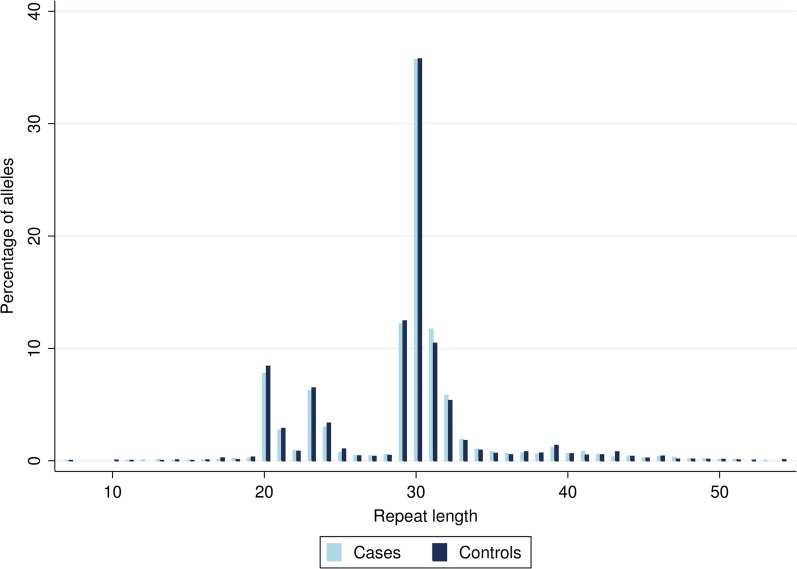
Percentage of FMR1 alleles of each length in early menopause cases (n = 4236) and controls (n = 4430).